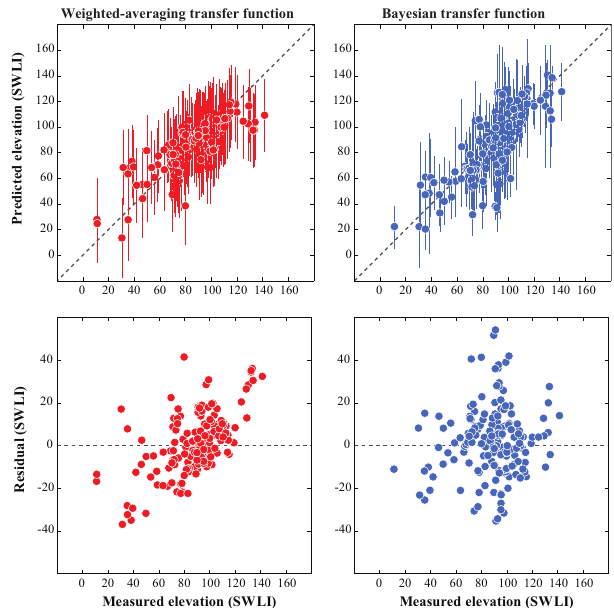
Figure 5. Cross-validation of the modern training set for the weighted averaging transfer function (red) and the Bayesian trans- fer function (blue). Upper panels are measured vs. predicted ele- vations in standardized water-level index (SWLI) units, with lines representing ± 2 σ uncertainty for prediction. Lower panels show the (observed–predicted)